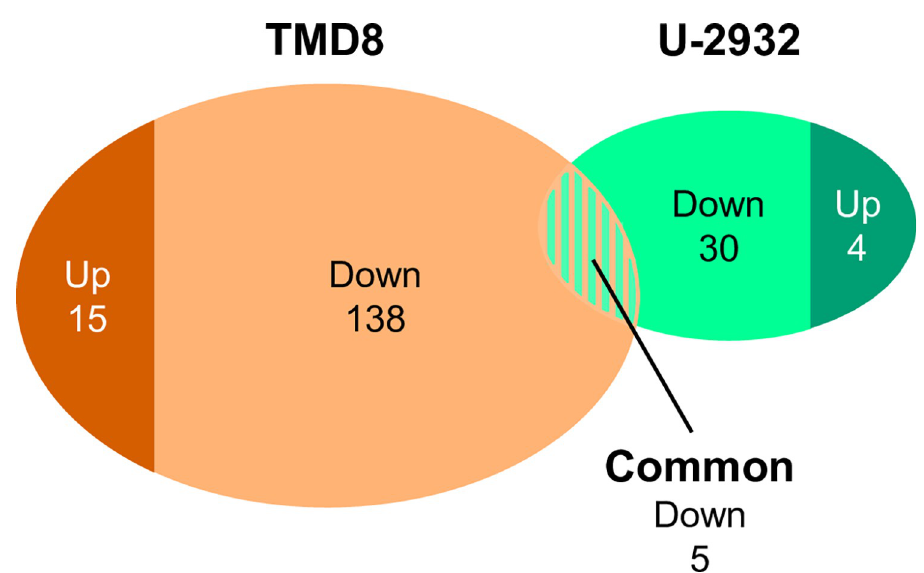
Fig 4. Number of upregulated or downregulated phosphorylation sites in TMD8 and U-2932 cells. https://doi.org/10.1371/journal.pone.0282166.g004 addition to ERK1 activation loop phosphorylation on Tyr-204, two sites in the MAPK path- way-associated enzymes Raf-1 and ribosomal S6 kinase 1 (RSK1) were repressed upon tirabru- tinib treatment on Ser-1055 and Ser-741, respectively. Although the responsible kinase for C- terminal Ser-741 phosphorylation on RSK1 is not yet known, Raf-1 phosphorylation on Ser- 1055 (according to the protein isoform assignment in our database search, identical with Ser- 642 in the UniProtKB entry P04049) is known to be directly phosphorylated by ERK kinases [41]. We also detected reproducible inhibition of phosphosites on the related protein kinases PKD2 and PKD3/PKC ν , including repression of Ser-710, which is known to lead to catalytic activity of PKD2 and Ser-735, which in turn, is reported to coincide with the kinase activation of PKD3/PKC ν [42,43]. Regarding transcription factors, activating transcription factor 2 (ATF2) phosphorylation was reduced by approximately 50% on the adjacent residues Thr-69 and Thr-71, which have been reported to activate transcriptional factor activity of ATF2 [44]. Thr-71 phosphorylation has been reported downstream of the Ras-MEK-ERK pathway [45]. We also detected reduced phosphorylation of Ser-501 of the erythroblast transformation-specific (ETS) domain-contain- ing protein Elk-1 (corresponds to Ser-422 in the UniProtKB entry P19419), a member of the Table 2. Significantly downregulated phosphosites in both TMD8 and U-2932 cells. Protein Gene Position Sequence window Tirabrutinib/ctrl. Tirabrutinib/ctrl. Tirabrutinib/ctrl. Tirabrutinib/ctrl. TMD8 rep. 1 TMD8 rep. 2 U-2932 rep. 1 U-2932 rep.